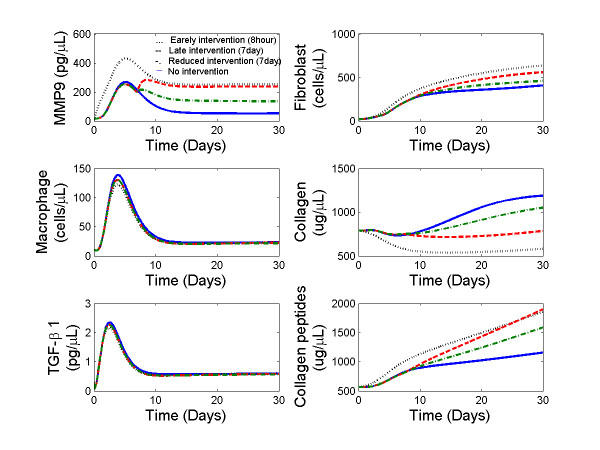
Temporal profiles of MMP-9, macrophages, TGF-β1, fibroblasts, collagen, and collagen peptides from days 0 to 30 post-MI at different MMP-9 interventions. The profiles include progressive changes in response to MMP-9 intervention at day 1 (····) and day 7 (red dash), as well as reduced MMP-9 intervention strength at day 7 post-MI (green dot-dash), and no intervention (blue line). The initial conditions were set to F(0) = 20 cells/mm3 and MΦ(0) = 5 cells/mm3, Tβ(0) = 0.21 pg/μL, M9A(0) = 7.1 pg/μL, C(0) = 839.5 μg/μL, CM9(0) = 447.6 μg/μL according to the measurements in normal myocardium.